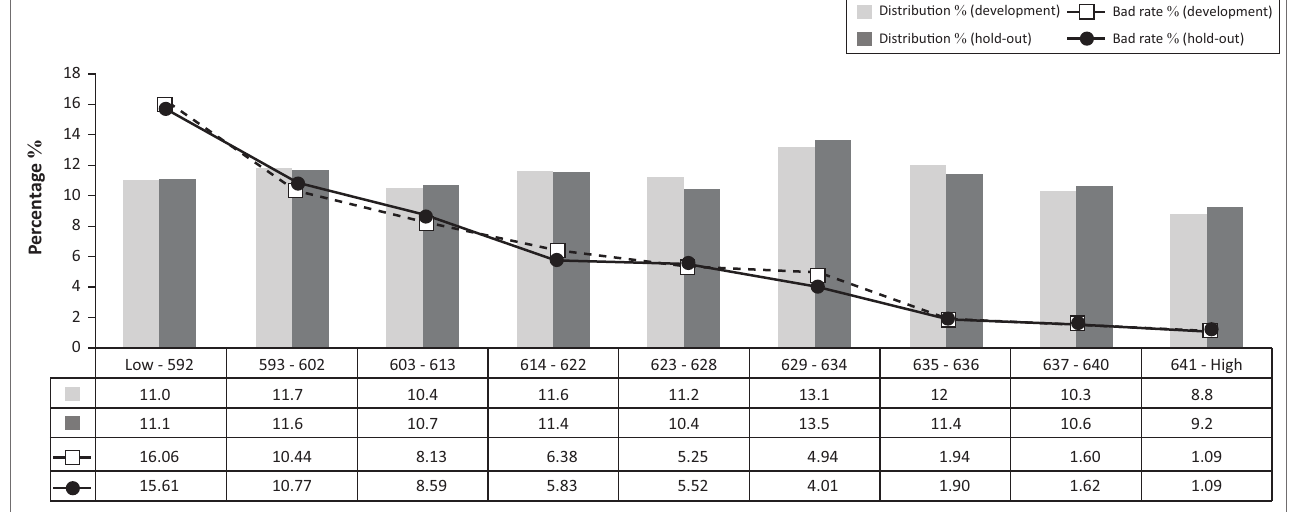
FIGURE 11: Score trend (Empirica score). TABLE 9: Credit Scoring Matrix Model (bad rate % per matrix cell). Bad rate